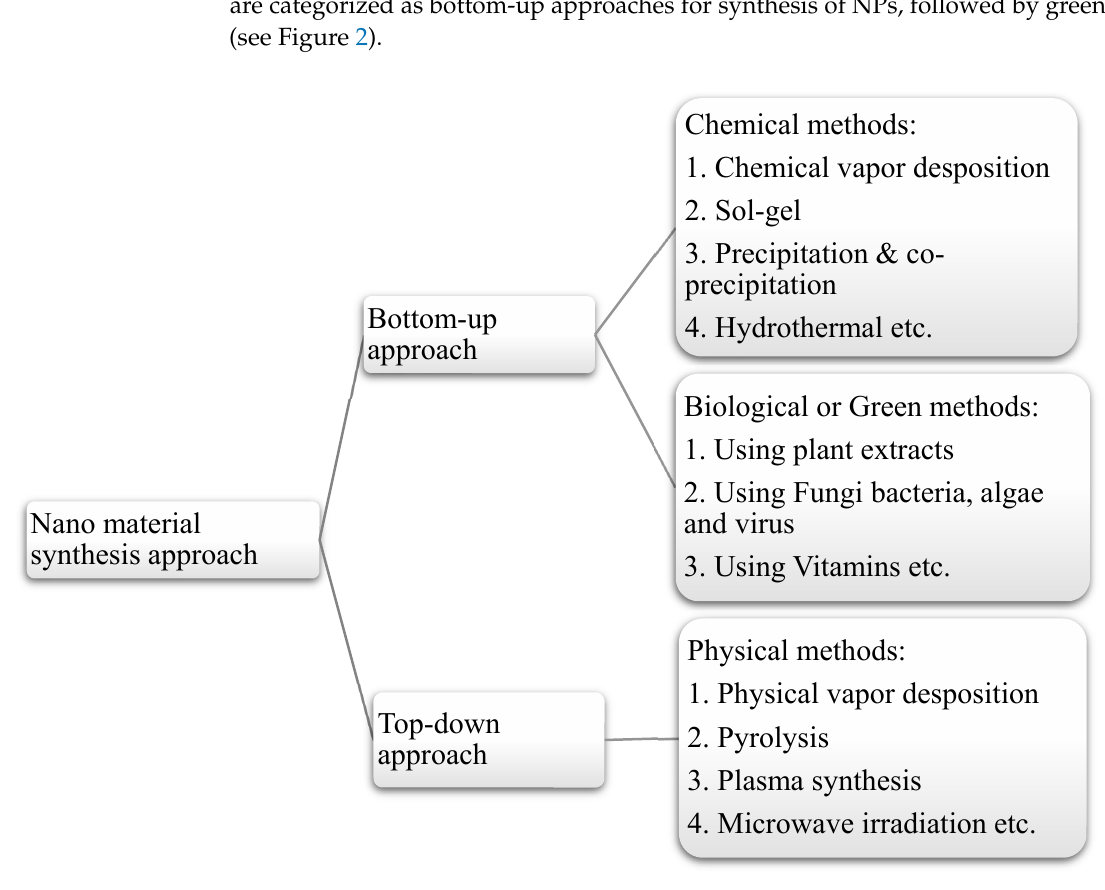
Figure 2. Synthesis approaches for nanomaterials .